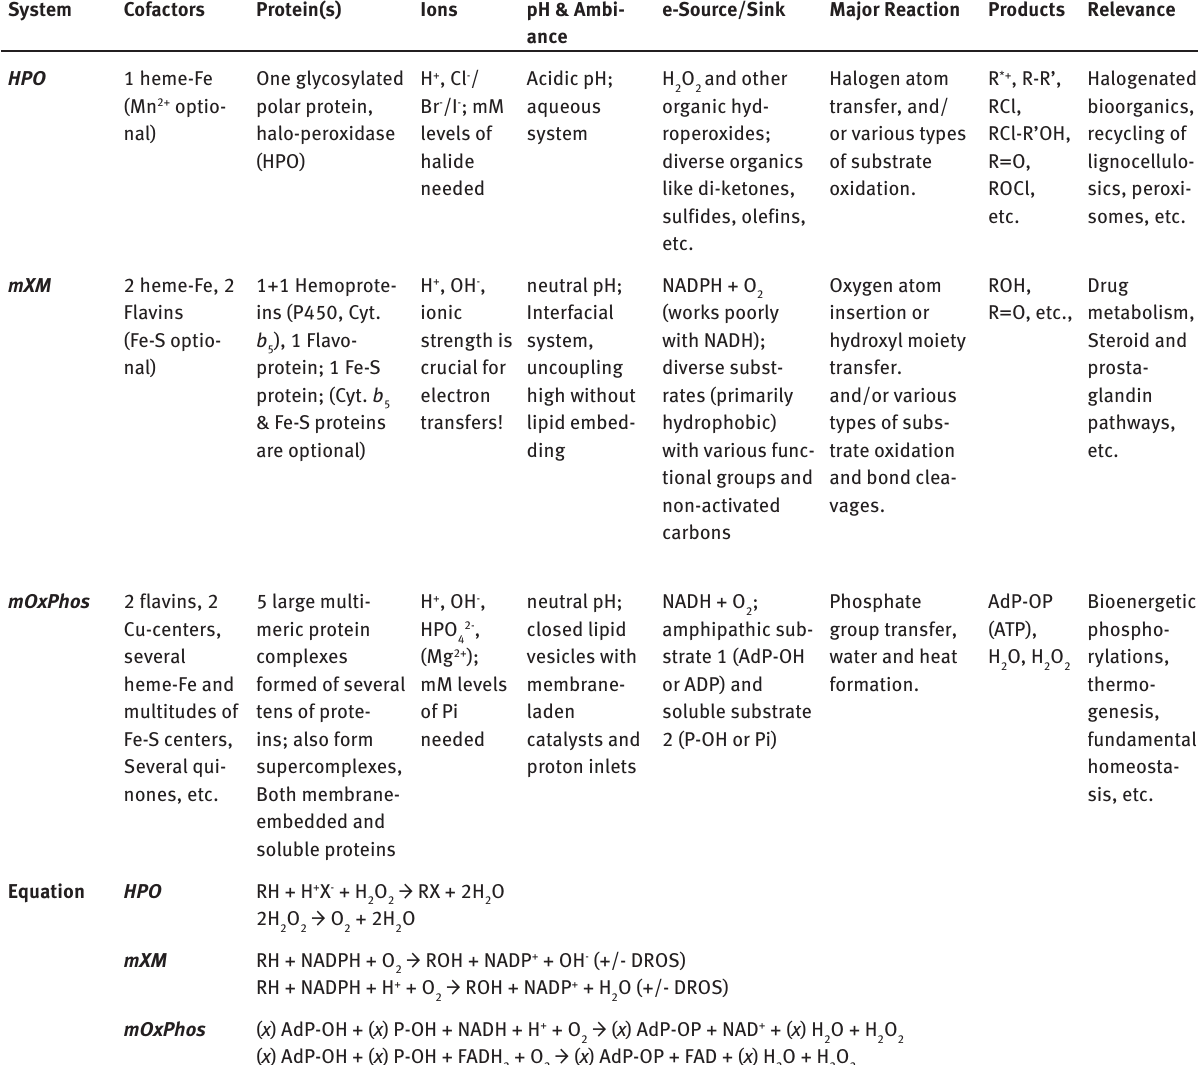
Table 1: Three reaction systems where murburn concept was applied to afford greater awareness and predictable accuracy. All three systems’ salient reactions can be simulated in vitro with the reductionist constitution of hemeprotein and superoxide. All reactions show complicated pH profiles, atypical kinetics and maverick effects upon the introduction of select